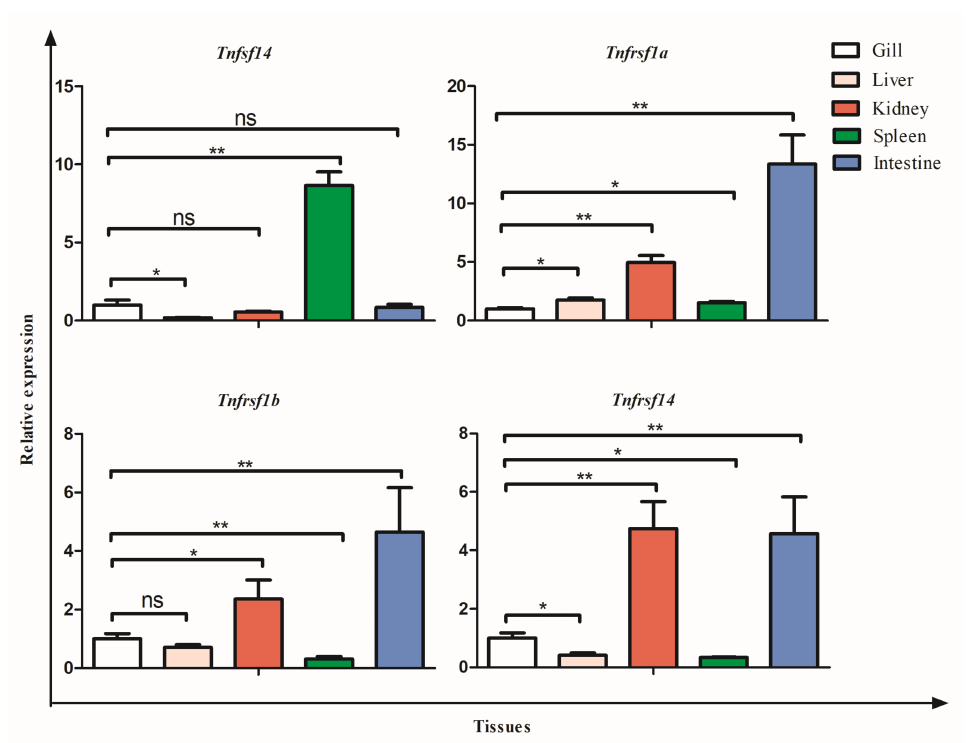
Figure 6. Expression analysis of tnfsf14 and tnfrsf genes in tissues. The expression levels of tissues were normalized to that of gills. Data are presented as mean + SEM ( n = 5). ns = no significant difference, * p < 0.05, ** p <